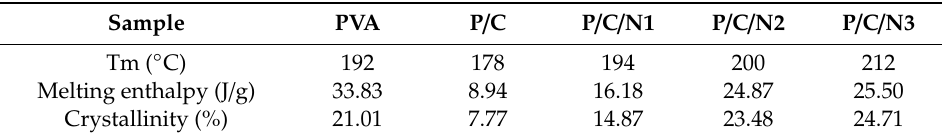
Figure 4. Differential scanning calorimetry (DSC) curves of the obtained composite films. Figure 4. Di ff erential scanning calorimetry (DSC) curves of the obtained composite films. Table 3. DSC data for the obtained composite Table 3. DSC data for the obtained composite films.